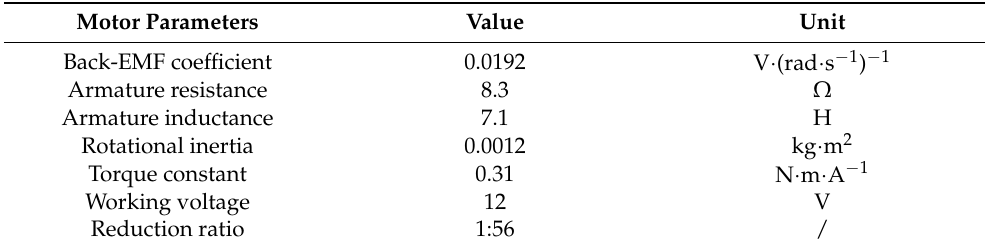
Table 1. Seeding motor parameters. Motor